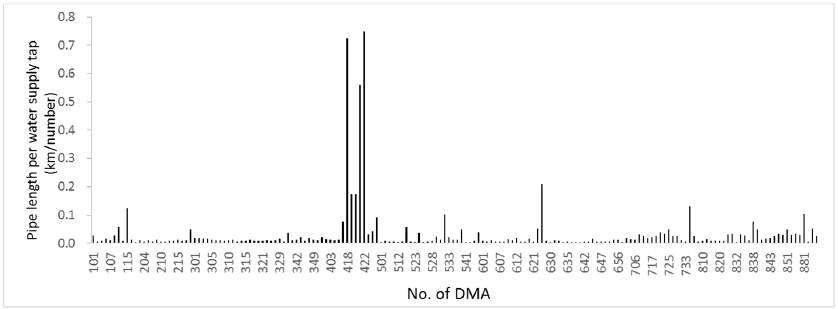
Figure 5. Data of Pipe Length per Demand Junction in Incheon’s DMAs.